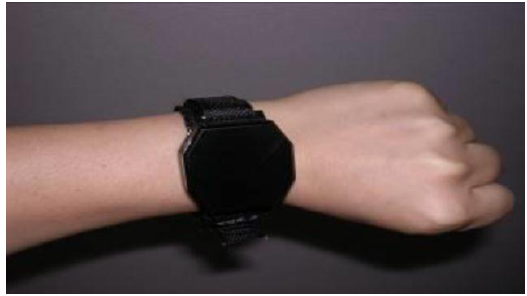
Figure 2. Ambulatory Monitoring Inc. Octagonal Basic actigraph device.